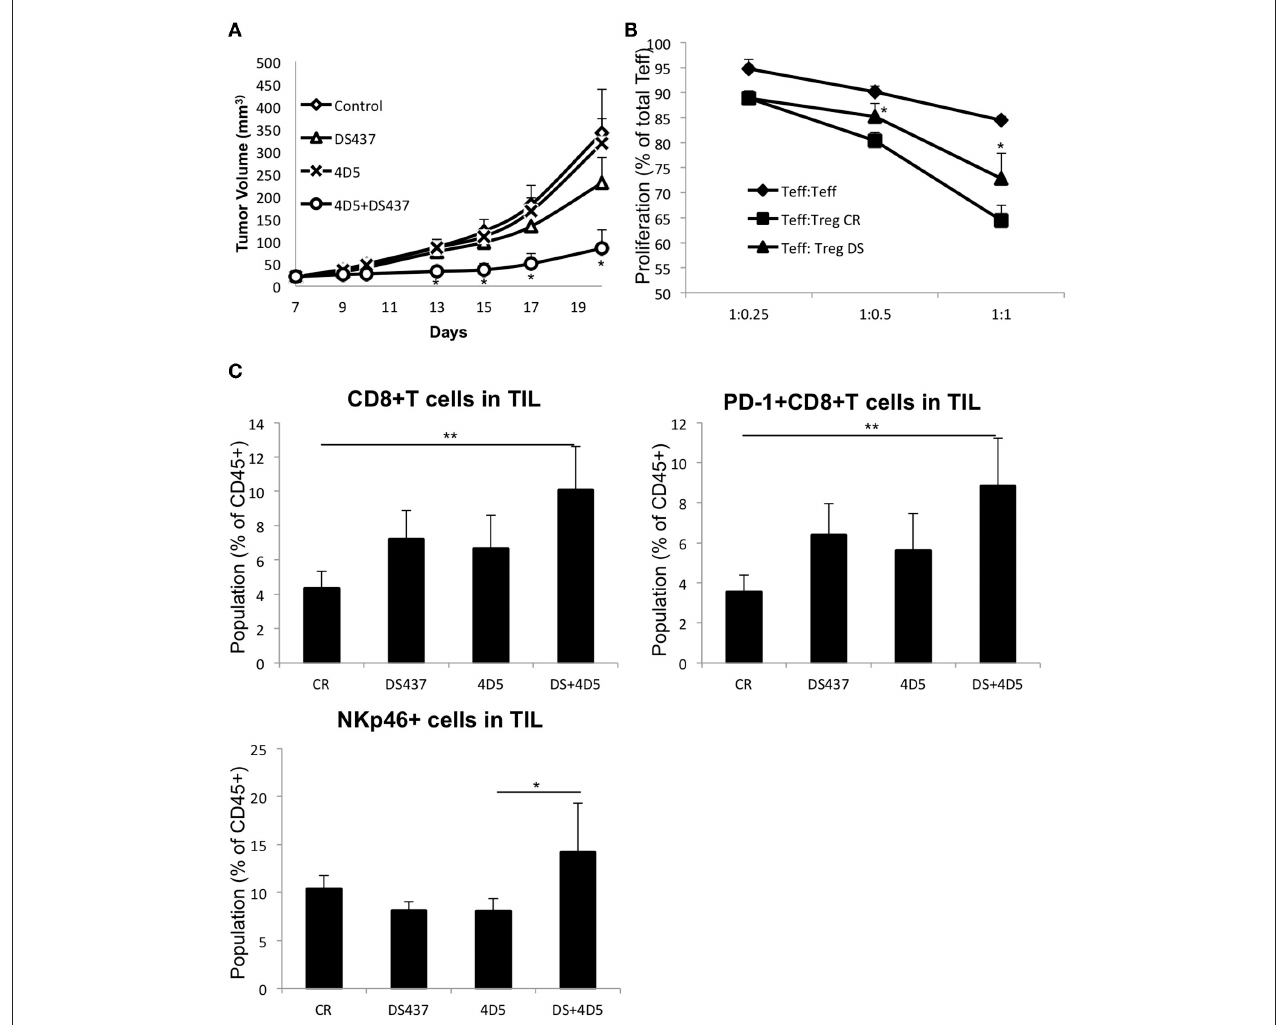
FIGURE 7 | Effect of PRMT5 inhibitor DS-437 on targeted therapy. (A) effect of DS-437 combined with anti-erbB2 antibody 4D5 on tumor size in CT26Her2 tumor model. CT26Her2 tumor cells (0.5 × 10 6 ) were injected subcutaneously into Balb/c mice that were treated with control PBS, 4D5 (5 mg/kg, twice per week), DS-437 (10 mg/kg, 5 times per week), or both 4D5 and DS-437. Data represent mean + SEM. One way ANOVA with Tukey HSD test was performed to compare the difference in the tumor size of different treatment groups. (B) function of Tregs in tumor bearing mice. Teffs and Tregs of PBS (CR) or DS-437 (DS) treated mouse lymph nodes were collected by sorting as described above. Teffs were labeled with CTV and stimulated with dynabeads CD3/CD28 beads (0.2 µ l/well) with or without Tregs as indicated ratios. After 3 days of culture, proliferation of Teffs were analyzed by flow cytometry. The error bars indicate the SD value. * P < 0.05 with control groups calculated by student t -test. (C) TIL were obtained after treatment as in (A) and the cell population analyzed by flow cytometry (4 mice per group, one tumor from each mouse). One way ANOVA with Tukey HSD test was performed to compare the difference in the populations of TIL of different groups. ** P < 0.01 (CR vs. DS + 4D5); * P < 0.05 (4D5 vs. DS +